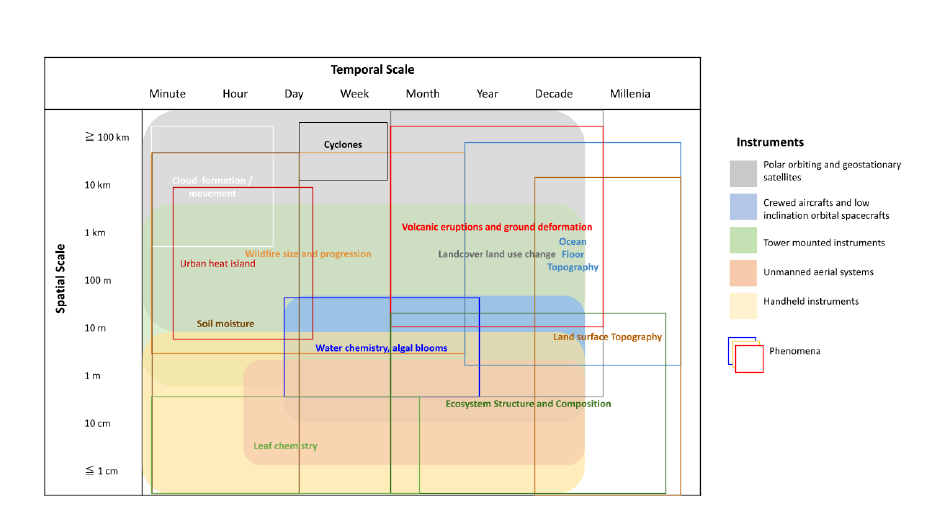
Figure 2: Variations in spatial and temporal scale in phenomena and remote sensing